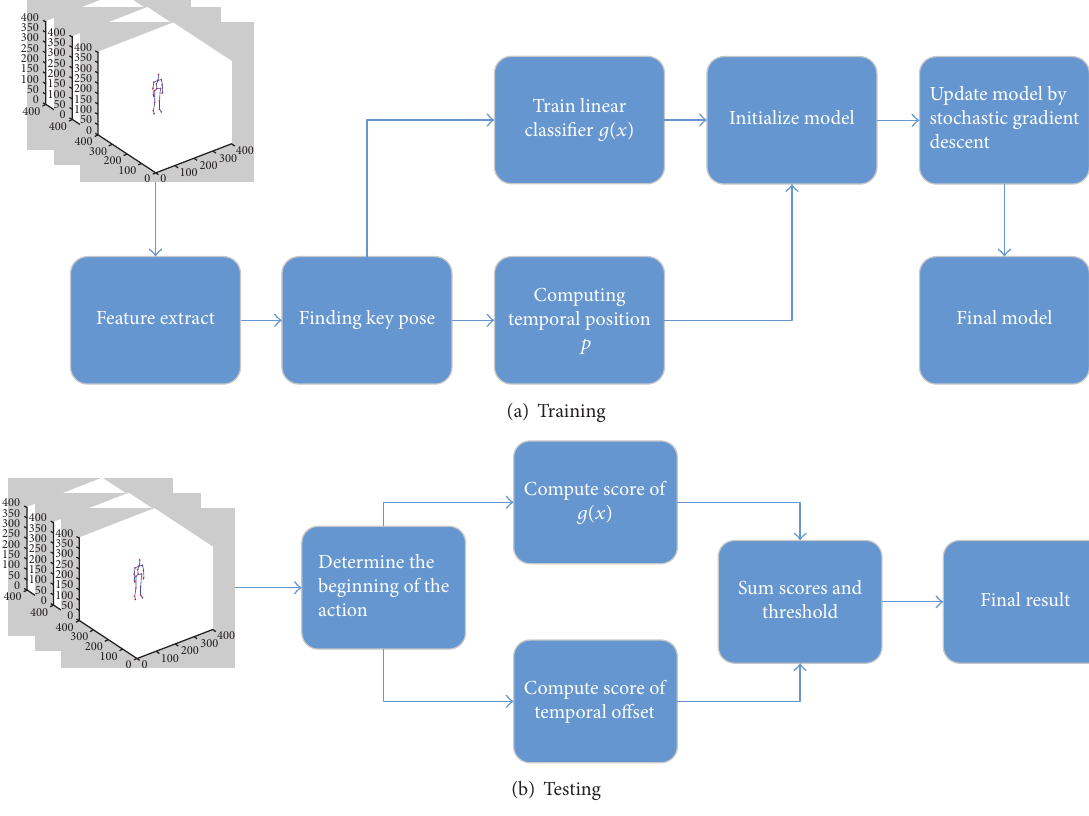
Figure 2: Structure of our